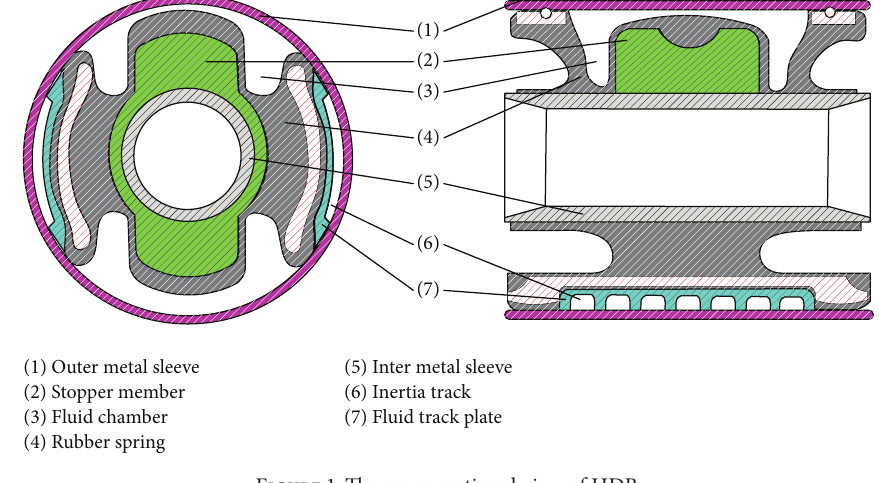
Figure 1: The cross-sectional view of HDB.